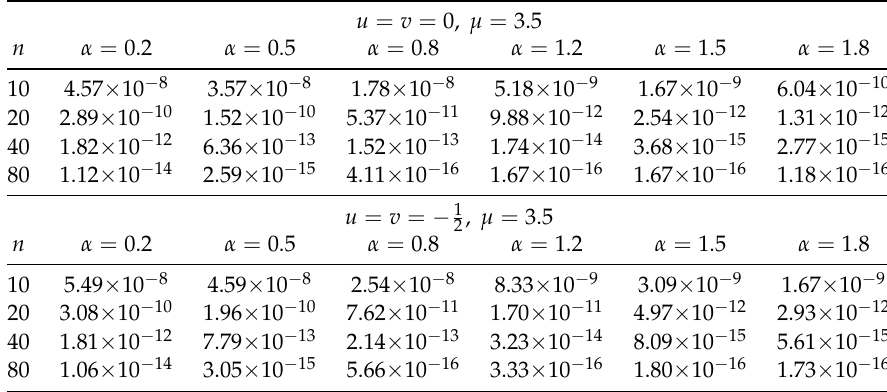
Table 1. The absolute errors for Example